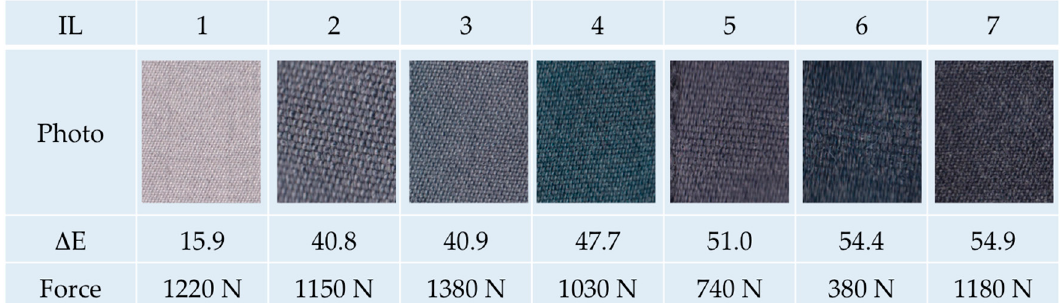
Figure 1. Dyeing of amorphous m-aramid fabrics with Acid Black 194 in various ionic liquids at 180 °C (photo, color distance and tensile strength, 1 = Tis(2-hydroxyethyl)methylammoniumethylsulfate, 2 = BMIM-triflate, 3 = EMIM-triflate, 4 = EMIM-dicyanamide, 5 = Tributylmethylphosphonium methylsulfate, 6 = EMIM-methanesulfonate, 7 = EMIM-EtSO 4 , tensile strength blank fabric = 1090 N).